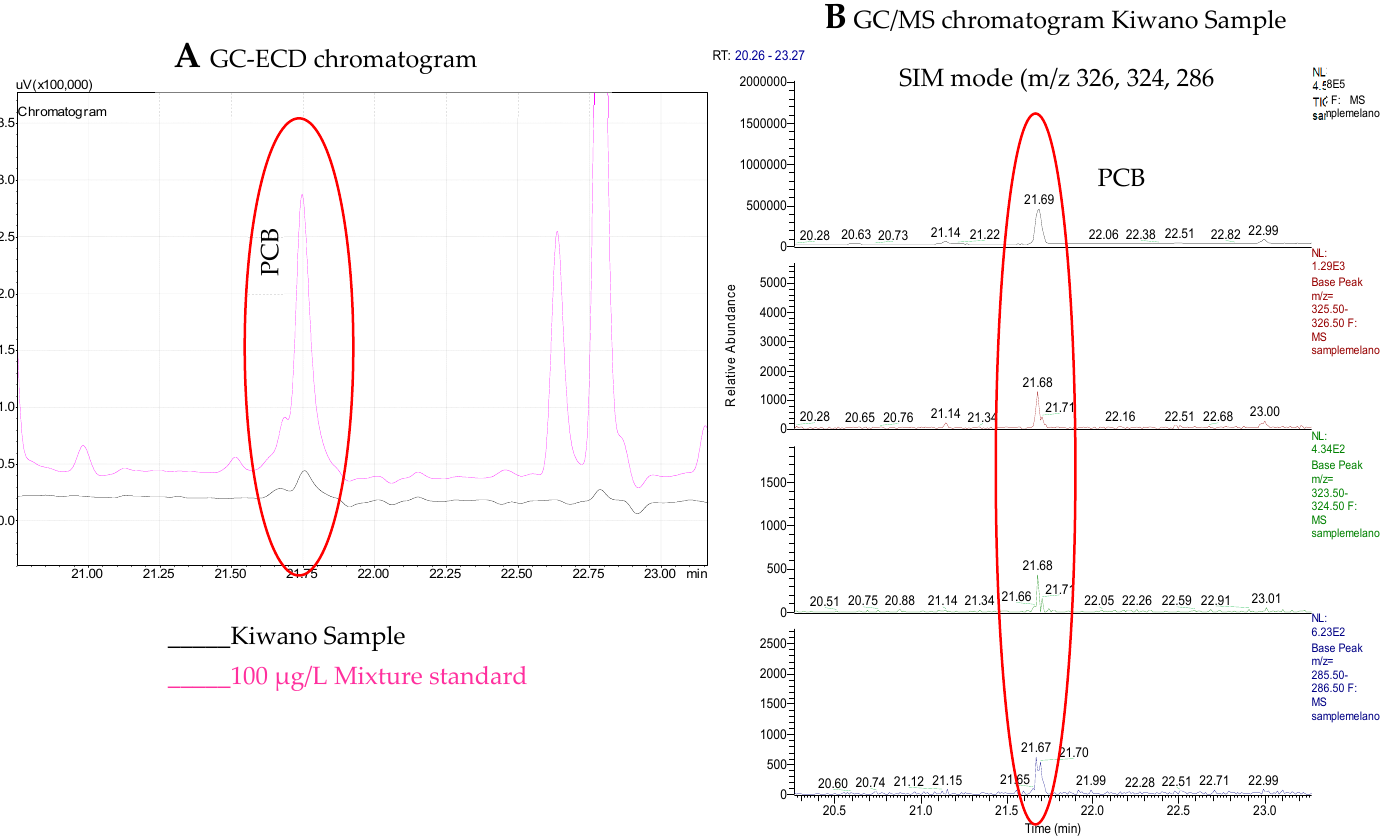
Figure 6. ( A ) GC-ECD chromatogram overlapping kiwano sample and 100 mg L − 1 mixture standard solution and ( B ) GC-MS spectrum of confirmation of the presence of PCB 101 ( m / z 286, 324, 326).